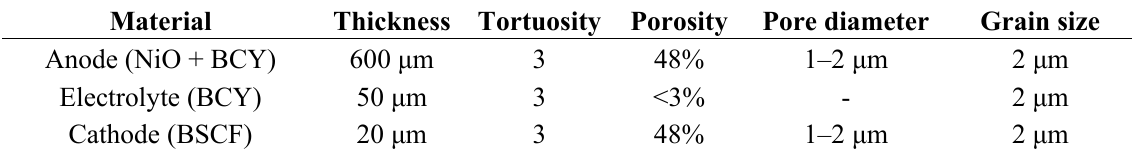
Table 4. Material properties from reference [15] used for the present validation of the model. Material